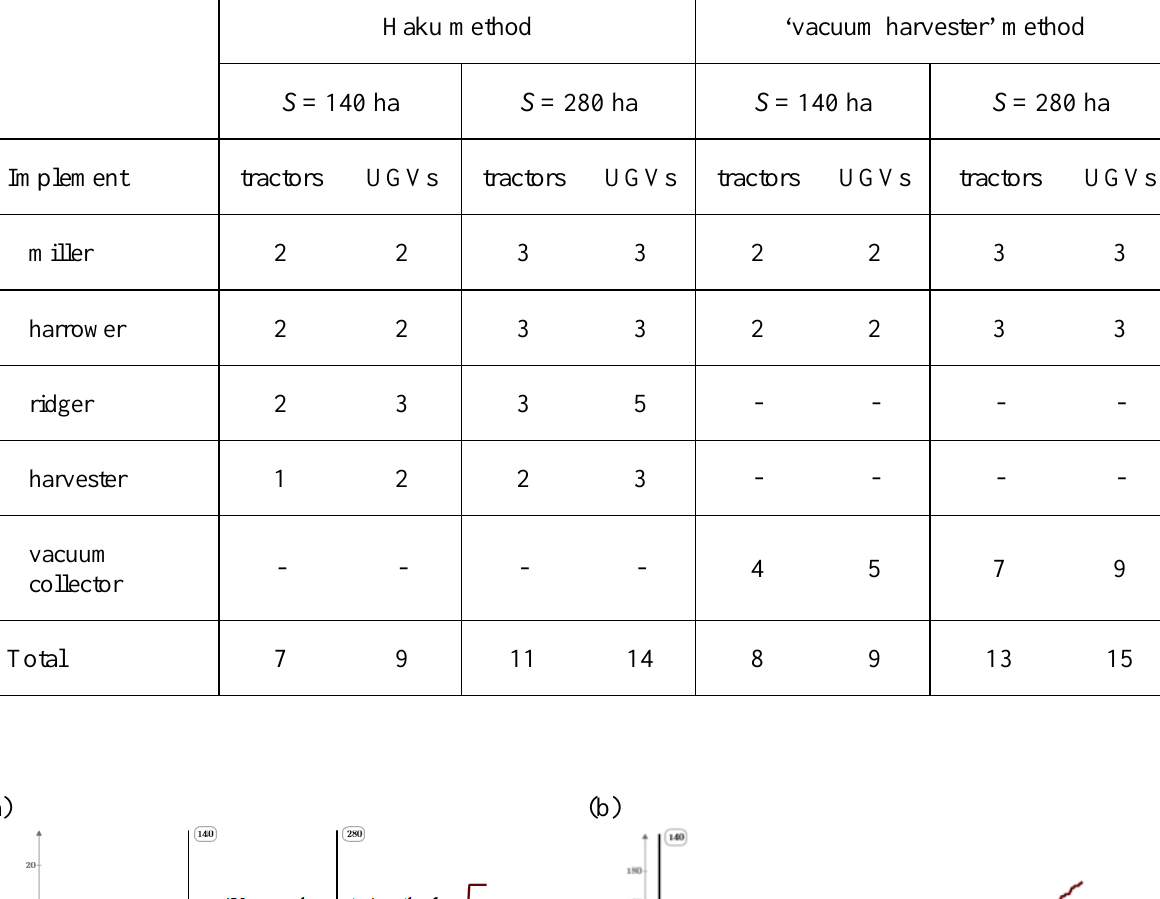
Table 1. The number of towing vehicles (conventional tractors or ‘Multiscope’ UGVs) required for the different phases of milled peat extraction according to the Haku method (milling, harrowing, ridging, harvesting) and the ‘vacuum harvester’ method (milling, harrowing, vacuum collection) for peat fields with surface areas ( S ) of 140 and 280 hectares. The information for peat fields with S = 140 ha was derived from the production data of peat extraction companies (Kraver AS, Estonia; Jiffy International, Netherlands), and the remaining data were calculated on the basis of available equipment specifications (Giprotorf 1986, Alakangas et al . 2012).